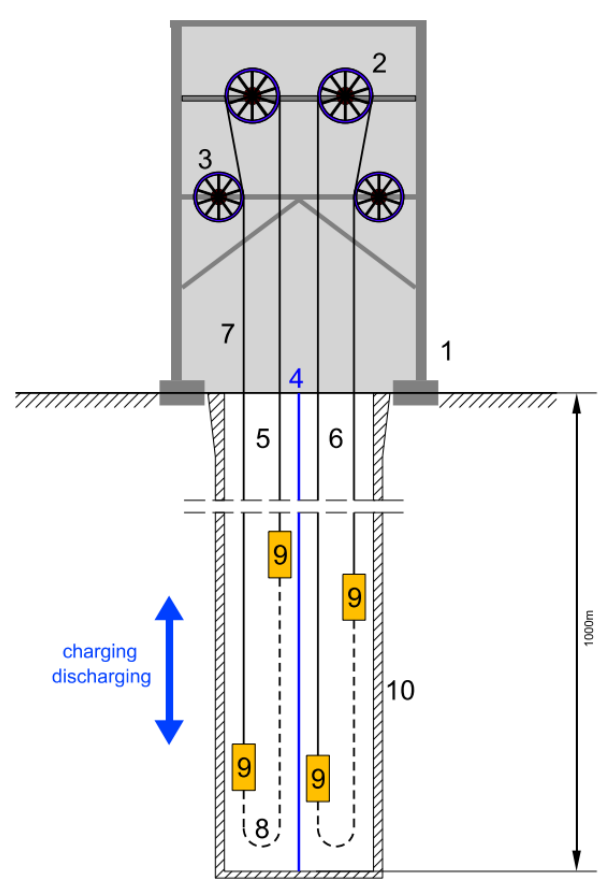
Figure 1. Schematic diagram of the Budryk shaft (own work) 1—hoist frame (tower), 2—Koepe pulley with motor, 3—deflection sheave, 4—separating beam, 5—west part shaft, 6—east part shaft, 7—hoisting ropes, 8—balance ropes, 9—skip cage (installed deadweight), 10—shaft tube with lin- ing.